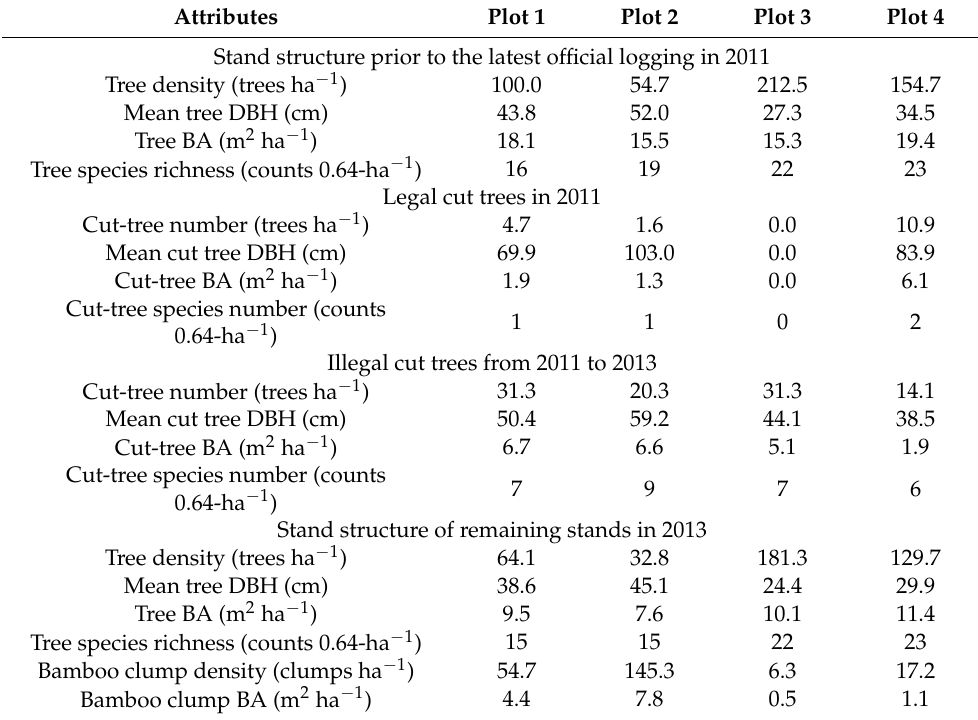
Table 1. Stand structure before and after the latest legal logging in 2011, and legally and illegally cut trees in four plots. Attributes Plot 1 Plot 2 Plot 3 Plot 4 Tree density (trees ha − 1